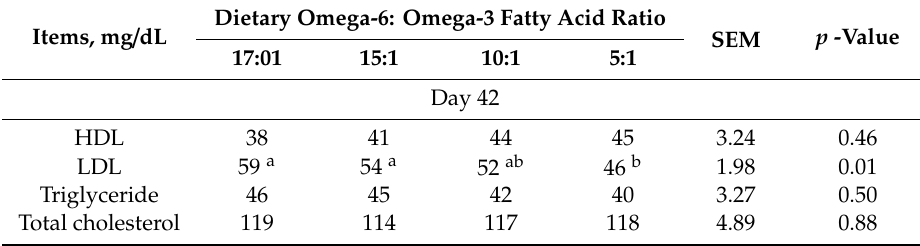
Table 5. E ff ect of omega-6: omega-3 fatty acid ratio on blood profile in growing pigs Dietary Omega-6: Omega-3 Fatty Acid Ratio Items, mg / dL